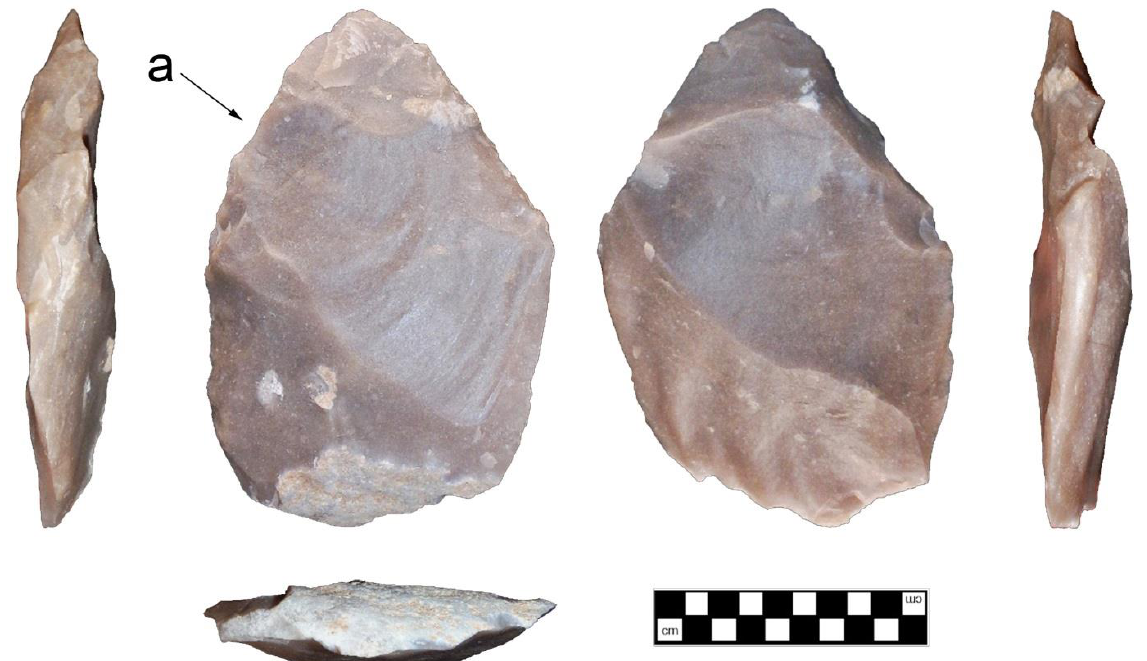
Figure 9. Replica 2 biface core after removal of full-face flake 3